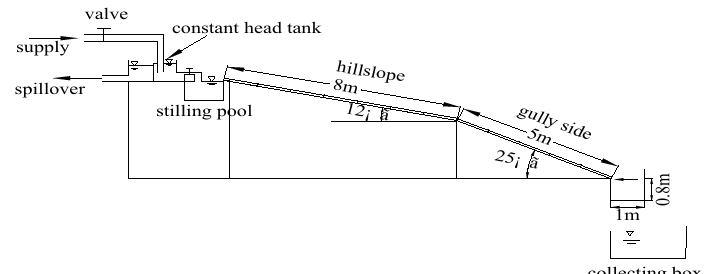
Fig. 1 The experimental soil bed of the hillslope-gully side erosion system Experimental set-up